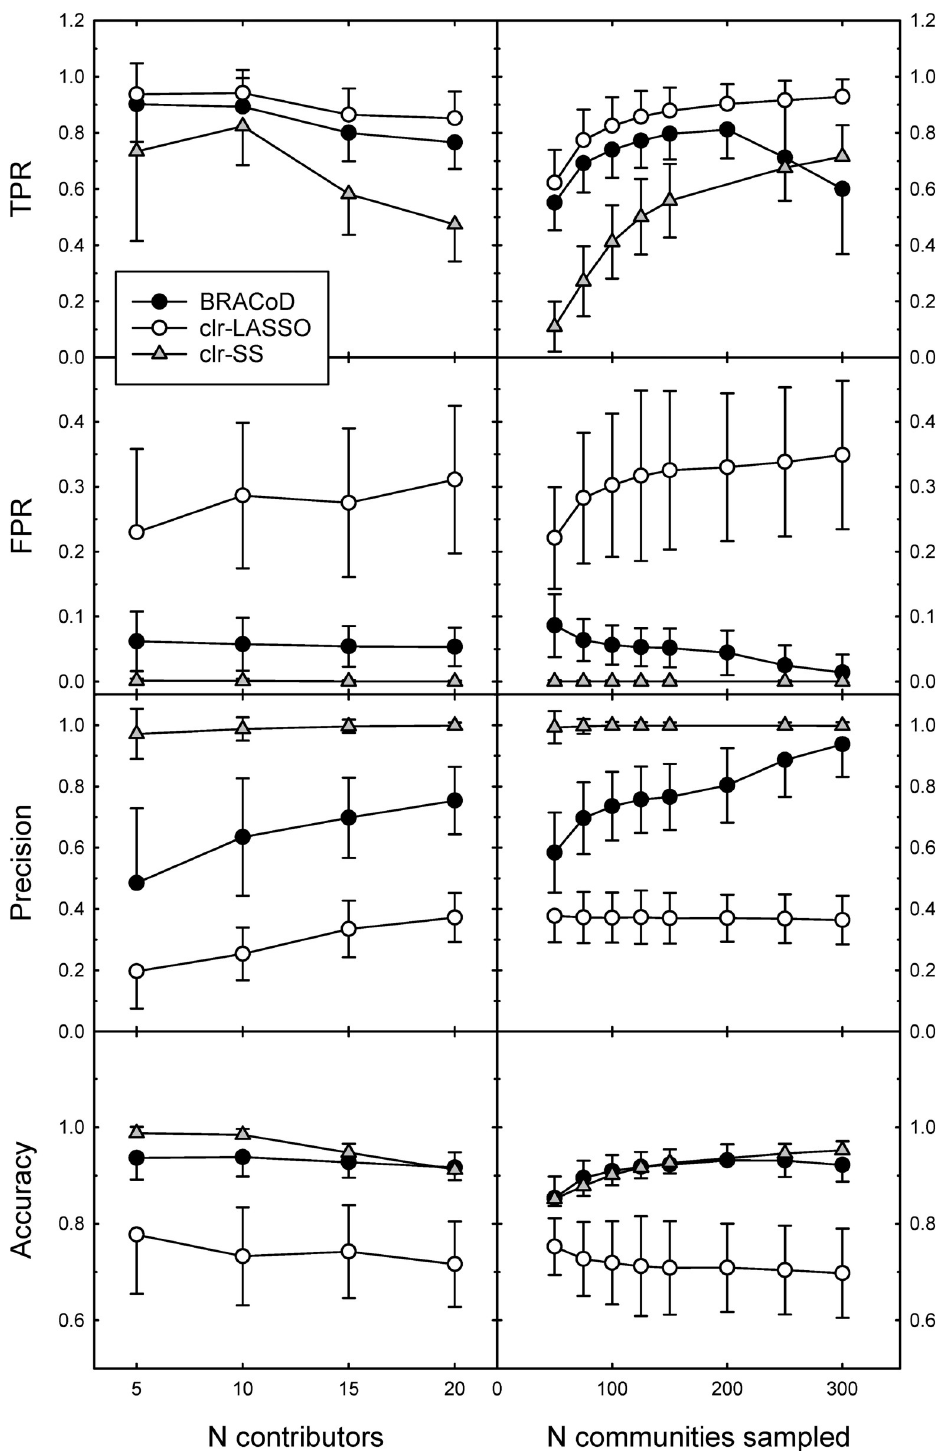
Fig 4. Parameter metrics in simulated communities. Method performance measures are plotted as a function of the number of contributing bacteria (left panels) or the total number of bacterial communities sampled (right panels). Values represent means ± SD for 1000 simulations with 100 non-contributing bacteria. Inclusion cut point for BRACoD = 0. For left hand panels, the number of community samples was set to 119, the number of rats in the bacterial